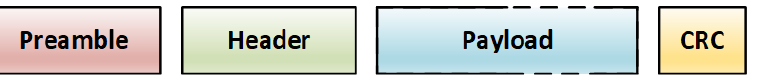
Figure 1. Structure of a LoRa packet.